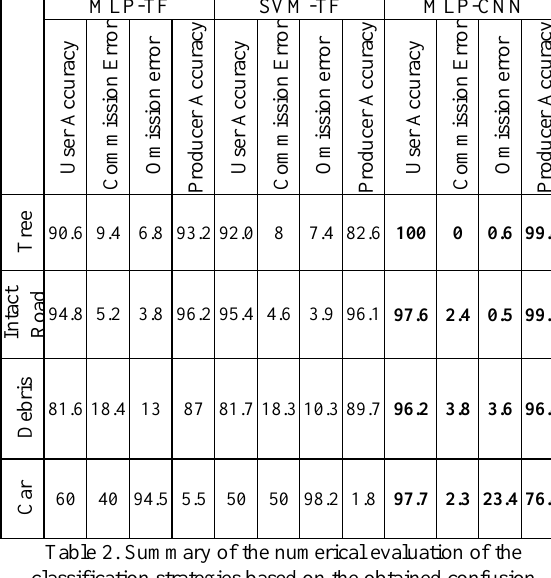
Table 2. Summary of the numerical evaluation of the classification strategies based on the obtained confusion matrices in Table 1.